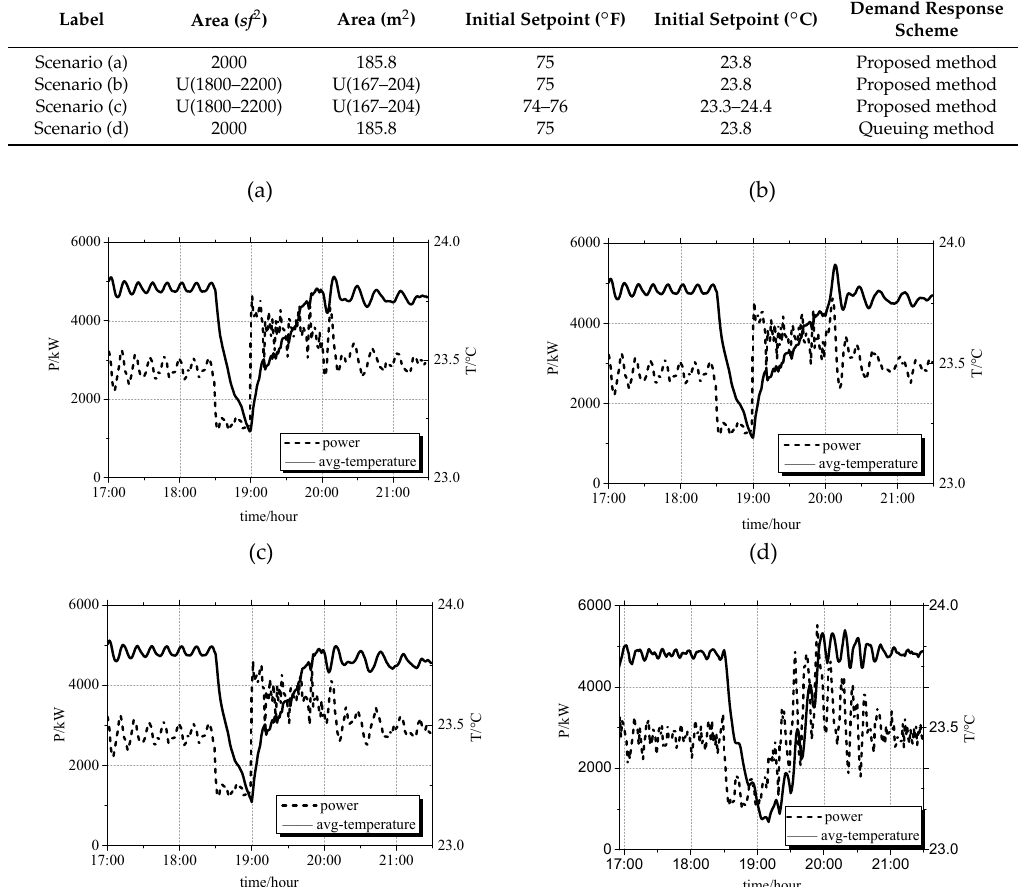
Figure 11. The load-average temperature curve of the aggregation under the demand response scheme. ( a ) represents the first scenario, ( b ) represents the second scenario, ( c ) represents the third scenario, and ( d ) represents the queuing method.